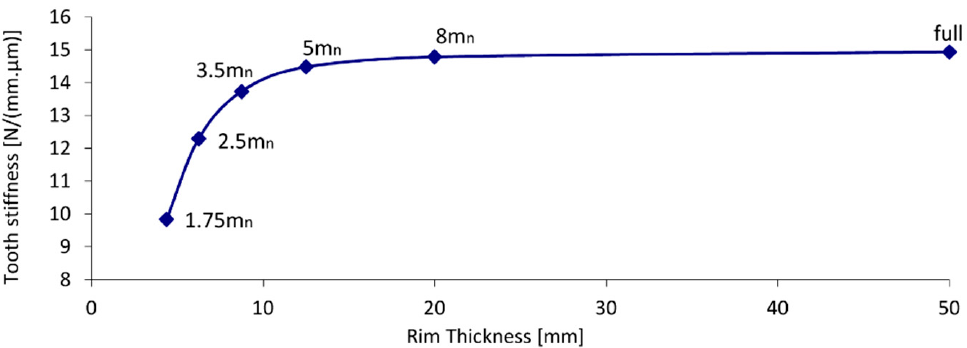
Figure 9. Influence of rim thickness on gear stiffness.